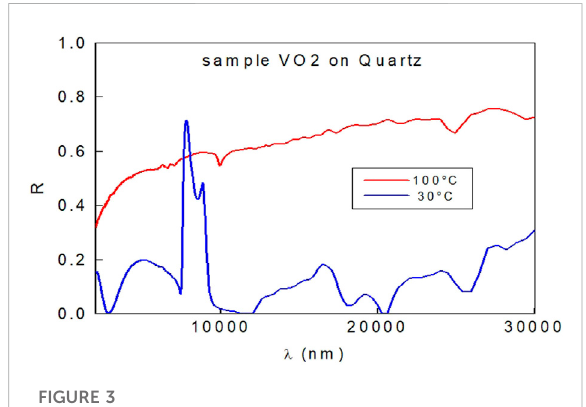
FIGURE 3 Re fl ectance of the VO 2 fi lm deposited on quartz plate measured with FTIR.